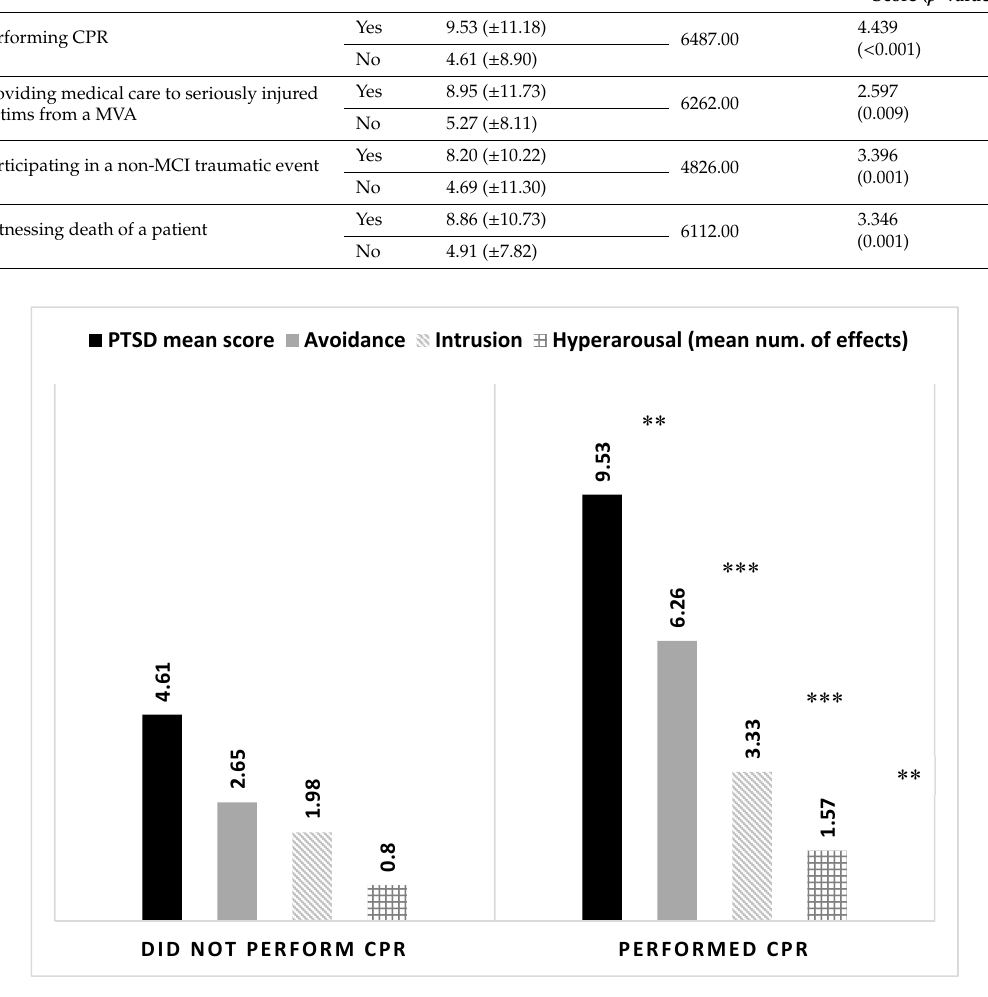
Figure 1. Mean levels of PTSD mean score and sub-components according to experience with provision of cardiopulmonary resuscitation (CPR) by MDA youth volunteers ( N = 236). Statistical di ff